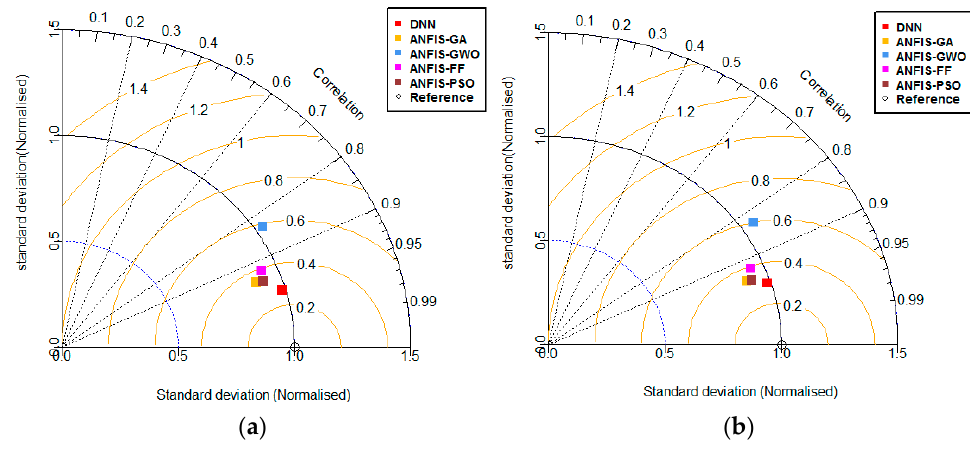
Figure 14. Taylor diagram in x direction ( a ) for training and ( b ) for testing phase.